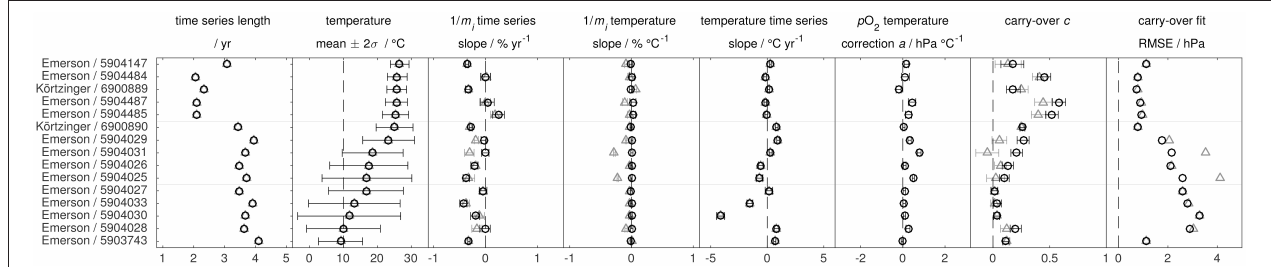
FIGURE 8 | Results of the in air analysis according to Equation (21) (gray triangles; without p O 2 - T slope a ) and (23) (black circles; with p O 2 - T slope a ) for optodes with individual multi-point laboratory calibration. Results between both approaches are very similar. The p O 2 - T corrections a are near zero, indicating a proper O 2 - T -response around 100 % O 2 saturation. Error bars give the 95 % confidence interval. All optodes are Aanderaa 4330